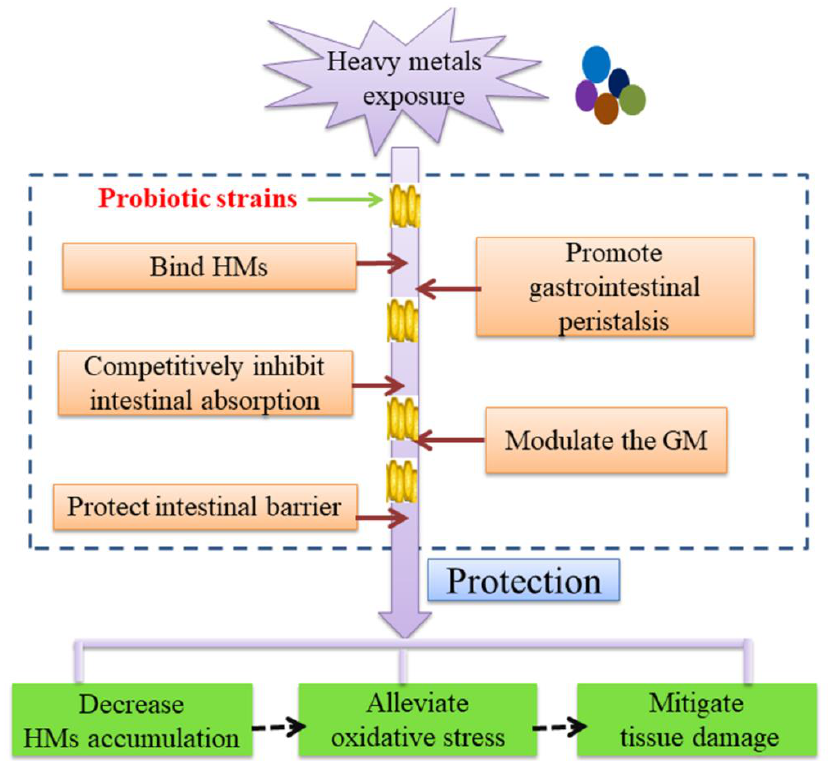
Figure 1. Proposed protective mechanisms of probiotics on HMs remediation in Figure 1 . Proposed protective mechanisms of probiotics on HMs remediation in vivo.